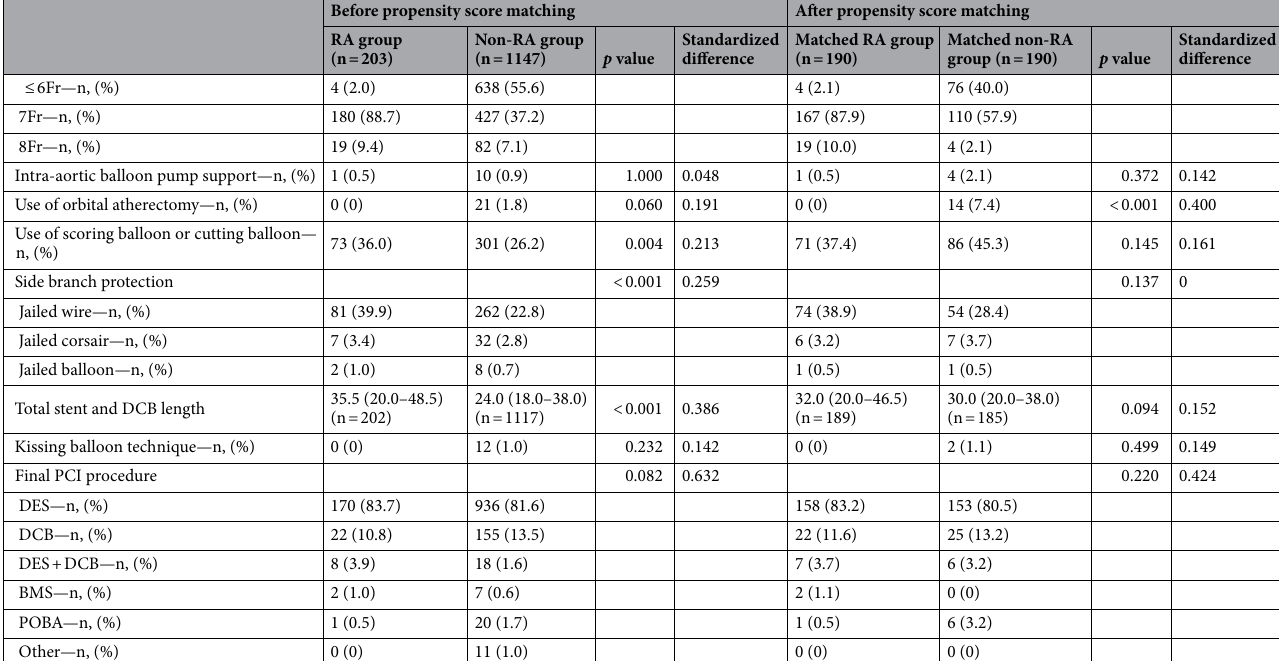
Table 1. Comparison of patients, lesions, and procedural characteristics between the RA and the non-RA groups before and after propensity score matching using the match tolerance set as a width of 0.30 multiplied by the SD of the propensity score distribution. Data are presented as a percentage for categorical variables or a median (quartile 1–quartile 3) for nonparametric variables. A Mann–Whitney U test was used